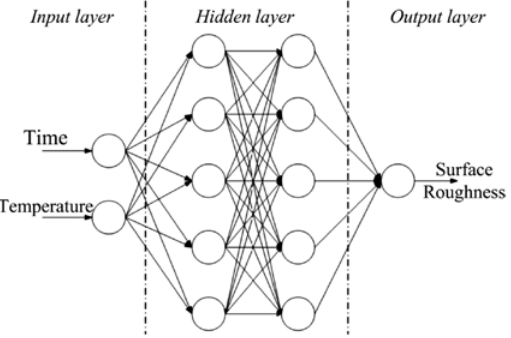
Figure 2 The structure of multilayer feed forward network used in this